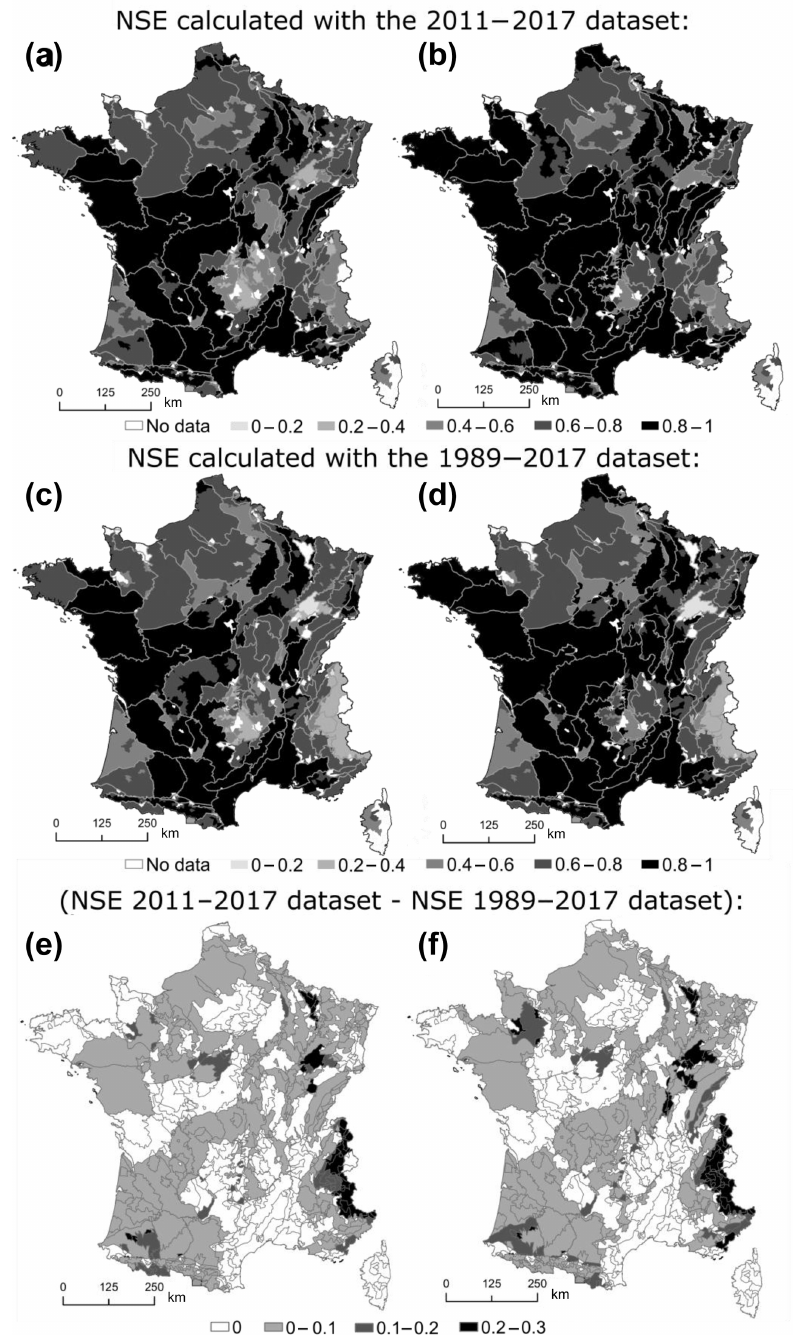
Figure 7. Map of Nash–Sutcliffe criteria (NSE) obtained for each HER2–HR combination between 2012 and 2016 with the 2011–2017 and 1989–2017 datasets according to (a) and (c) a log-linear regression (LLR) model; or (b) and (d) a logistic regression (LR) model. NSE differences between the 2011–2017 dataset and the 1989–2017 dataset are represented for (e) the LLR model and (f) the LR